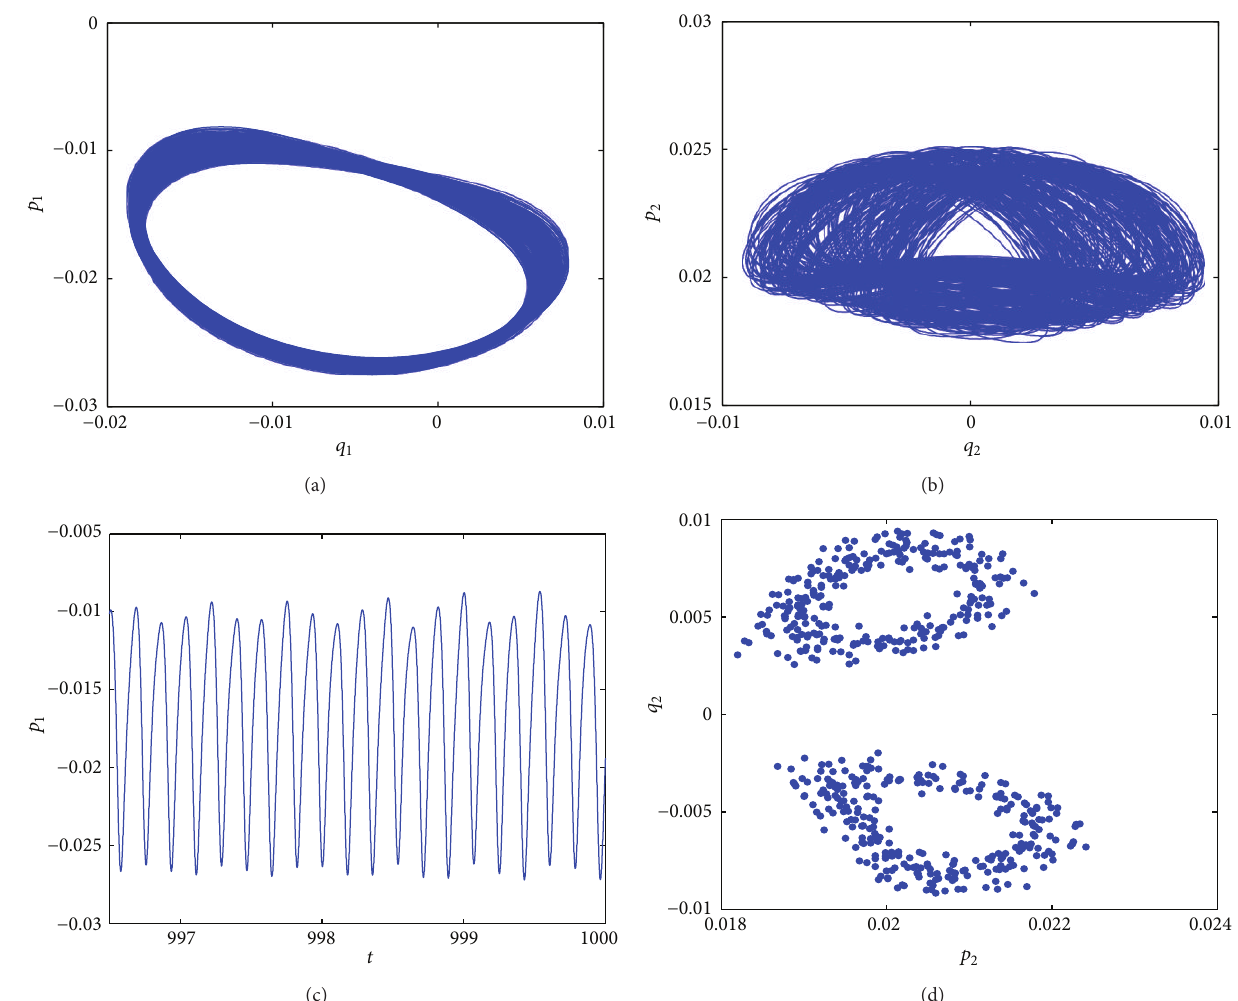
Figure 14: Phase portraits (a, b), time trace (c), and Poincare map (d) for 𝜎 2 = 116.4201 , 𝜇 = 0.05 , V 1 = 10 , and 𝛼 = 0 , 𝜎 1 = 92.39 .